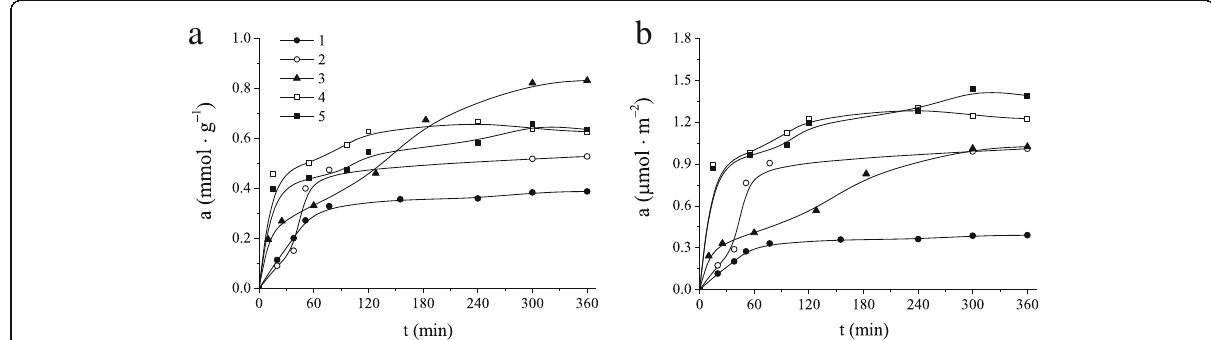
Fig. 5 Kinetic curves of benzene adsorption on MCM-41 ( 1 ), NH 2 -MCM-41 ( 2 ), β -CD-APTES-MCM-41 ( 3 ), β -CD-APTES 3 -MCM-41 ( 4 ), and β - CD-APTES 5 -MCM-41 (5) silicas per gram ( a ) or per square meter ( b ) of